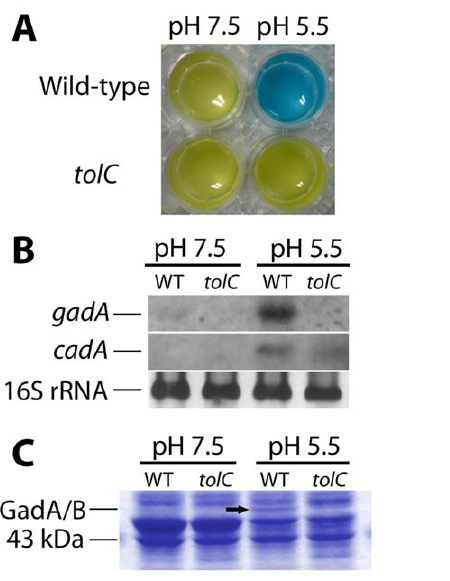
Figure 2. TolC is required for expression of the glutamate- dependent acid resistance system. E. coli wild-type MG1655 and its TolC-deficient derivative MG1655T ( tolC ::Tn 10 ) were assayed for glutamate decarboxylase activity, gadA mRNA expression, and GadA/B expression. A ) Both strains were tested for glutamate decarboxylase activity at pH 7.5 and pH 5.5 using the GAD reagent as described in Materials and Methods. The pH indicator dye bromocresol green changes from yellow to blue when L-glutamic acid is decarboxylated. There was almost no change in color with the tolC ::Tn 10 strain at pH 5.5. B ) Northern analysis of gadA and cadA mRNA at pH 7.5 and pH 5.5 with the wild-type and tolC ::Tn 10 strains; 16S rRNA bands are provided as a control. C ) A 53 kDa protein band (indicated by an arrow)